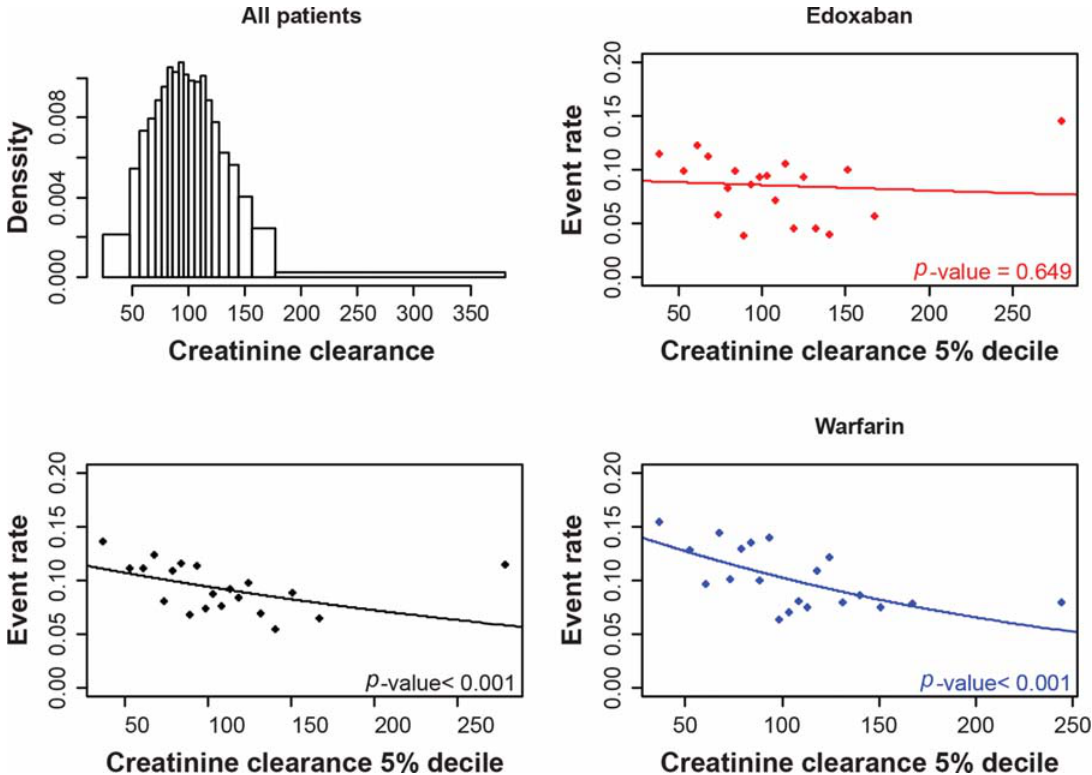
Fig. 5 The relationship between clinically relevant bleeding and creatinine clearance, overall and by treatment arm.